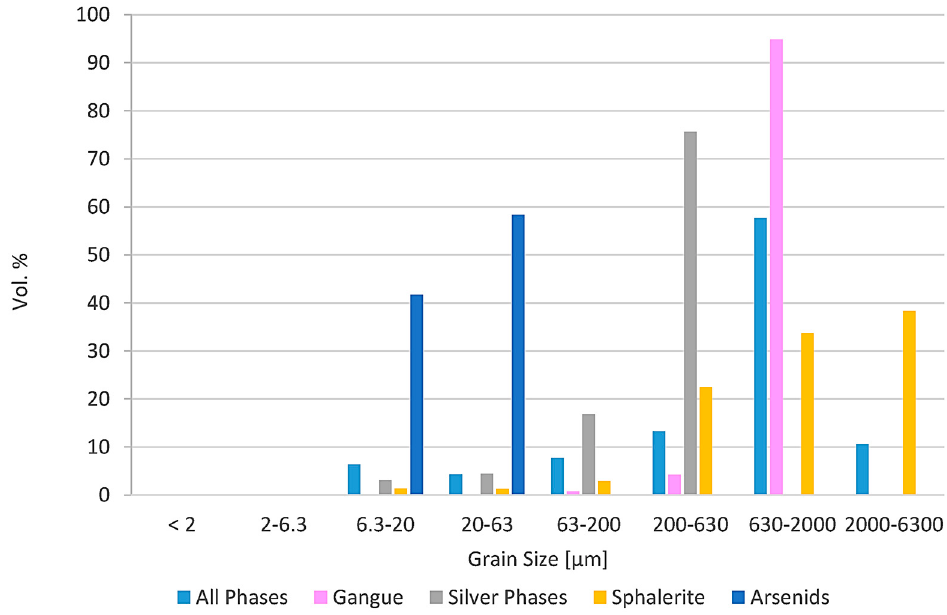
Figure 4. Grain Size of different phases from thin-section analysis. Based on this analysis, the target grain size was optimized before grinding. Silver phases were handled together due to their similar chemical character, except acanthite.